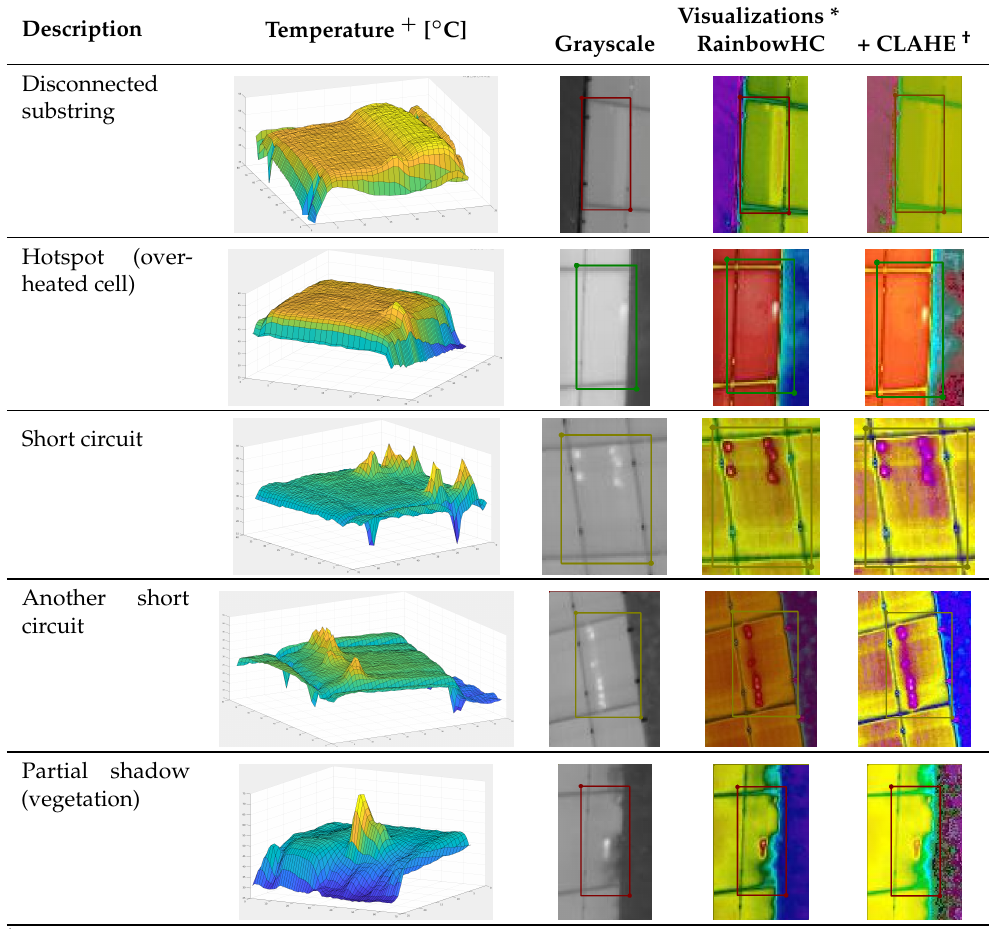
Table 2. Examples of IRT images of typical problems in PV installations.